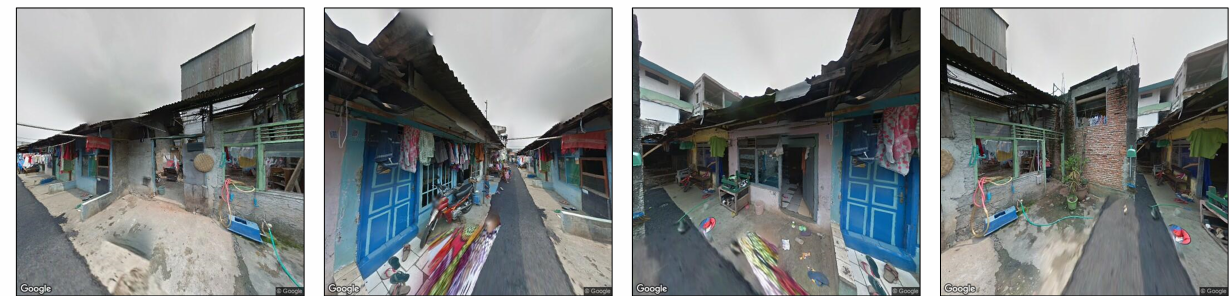
Figure 3. SVI captured in the cardinal directions at one slum location according to official slum reference map of